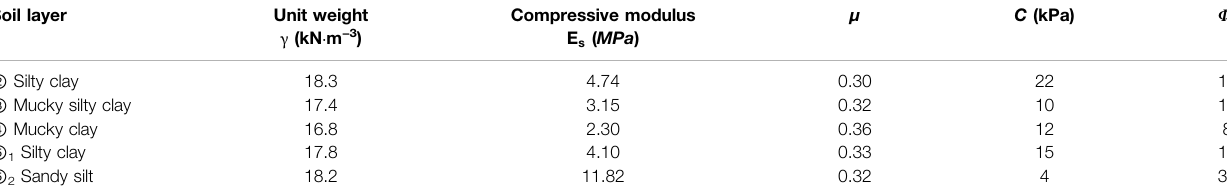
TABLE 1 | Physical and mechanical parameters of soils. Soil layer